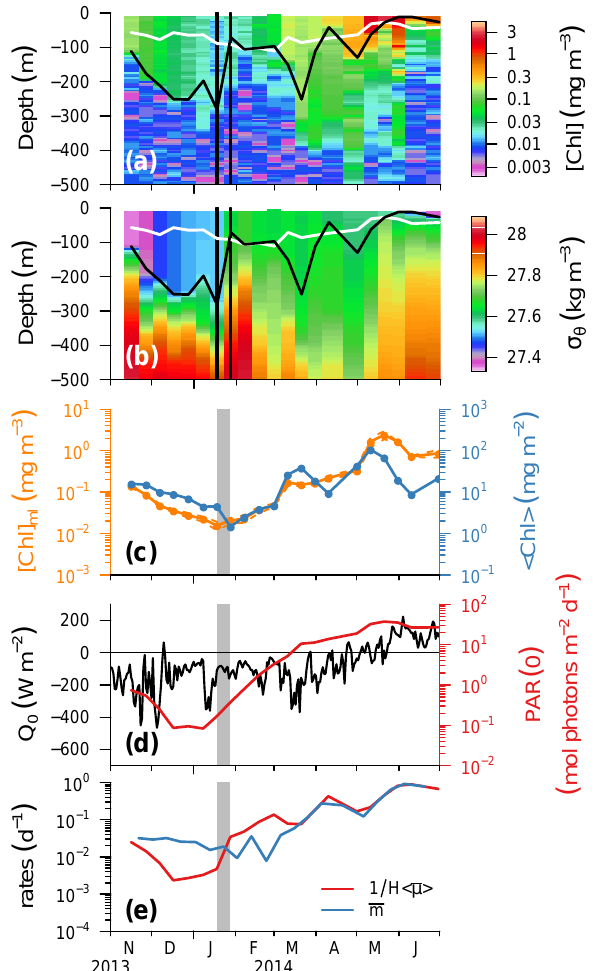
Figure 3. Same as Fig. 2, but for the float IMR7 during the winter– spring 2013–2014. The two black vertical lines and the gray shad- ing indicate the onset of the bloom. In panel (e) , the continuous red and blue lines are the daily mixed layer averaged division rate (1 /H< ¯ µ> ) and the phytoplankton loss rates ( m ), respectively, computed as discussed in Sect. 4.2.